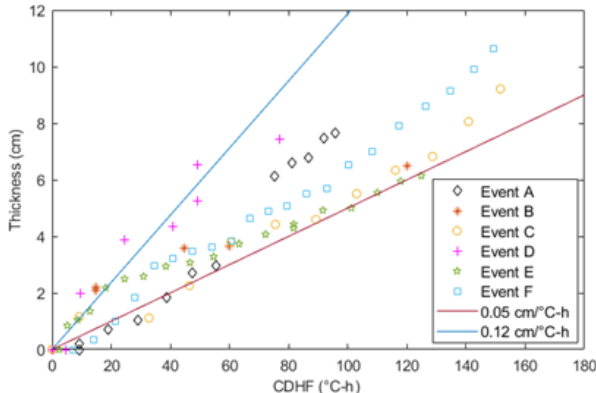
Figure 11. Time series plot of the measured anchor ice thickness during Event C on 3–4 December 2018 labelled with the differ- ent stages of anchor ice formation, growth, and release. Note that Stage 4 shows the “lifting” release mechanism before the total re- moval of the anchor ice accumulation.